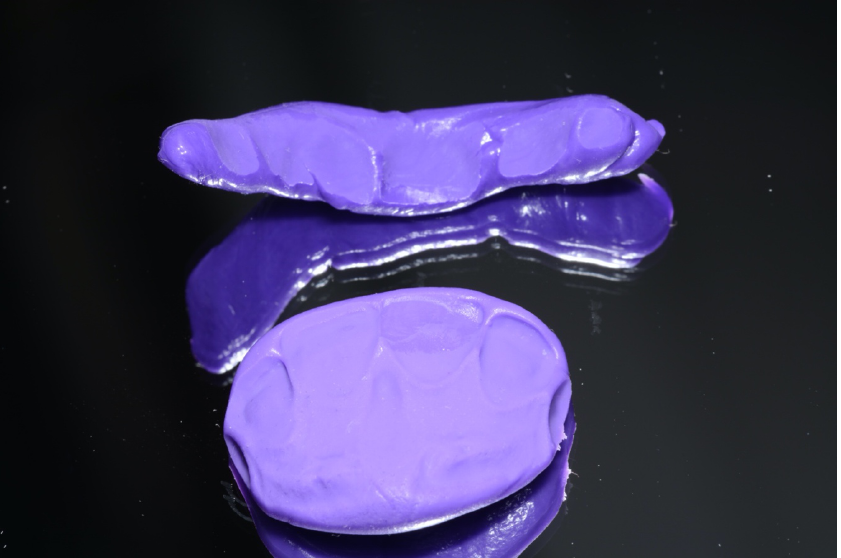
Figure 3. Layering key made of kneaded silicone (bottom), and kneading mass used to promote patient cooperation in the sense of the tell-show-feel-feel-do technique (top). (©Max Diekamp). Children 2020 , 7 , x FOR PEER REVIEW